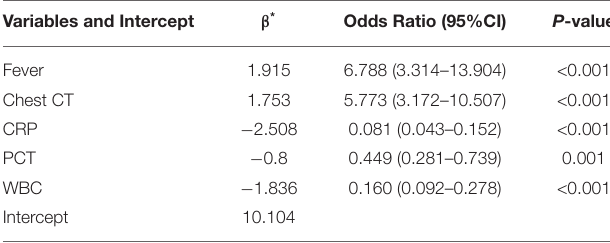
TABLE 2 | Multivariable logistic regression of potential predictors for screening COVID-19 in infectious acute abdomen patients (training